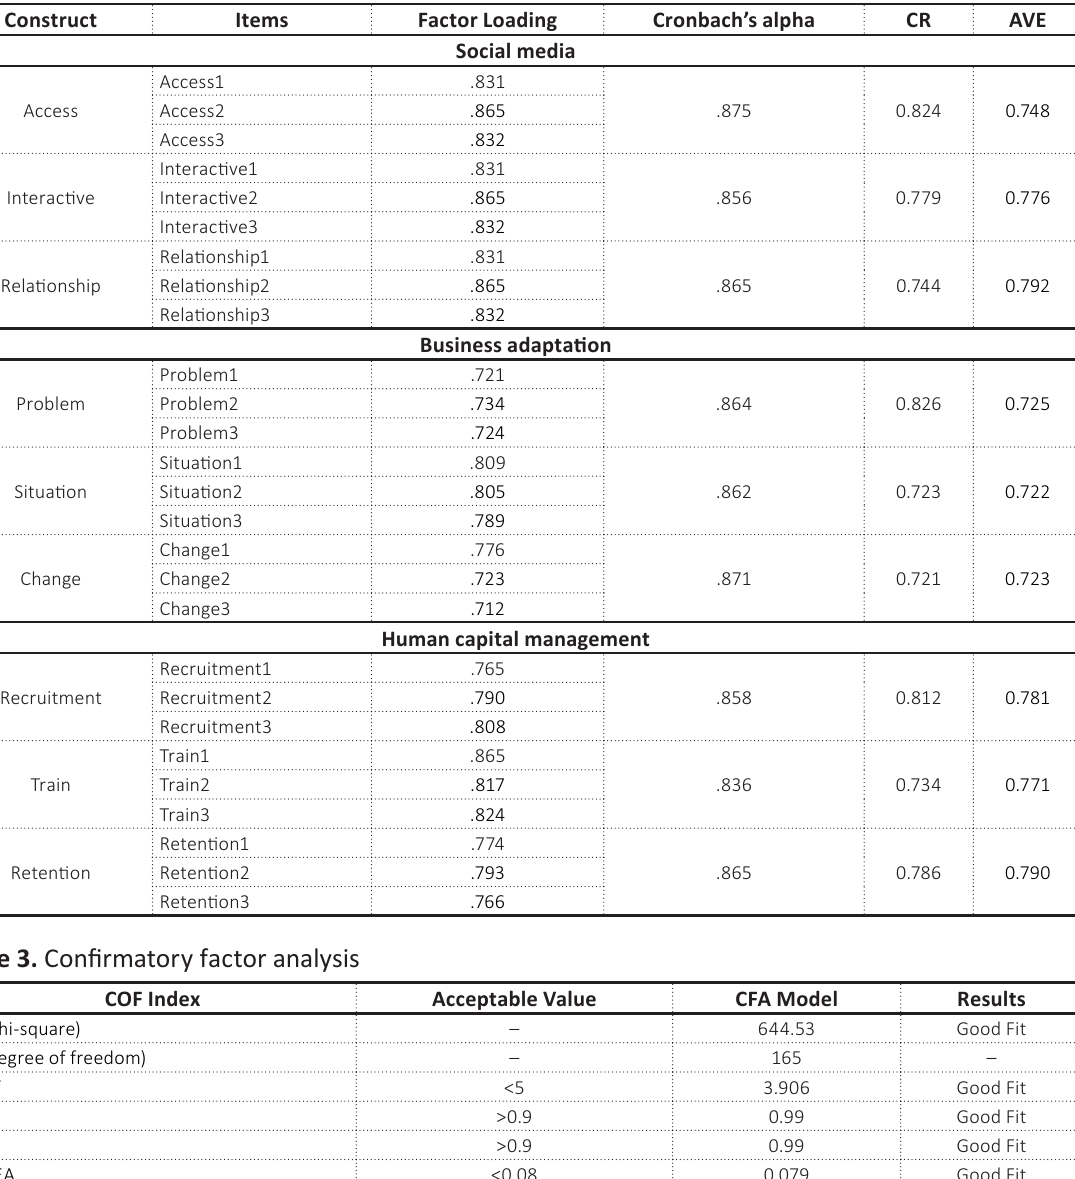
Table 2 (cont.). Measurement model